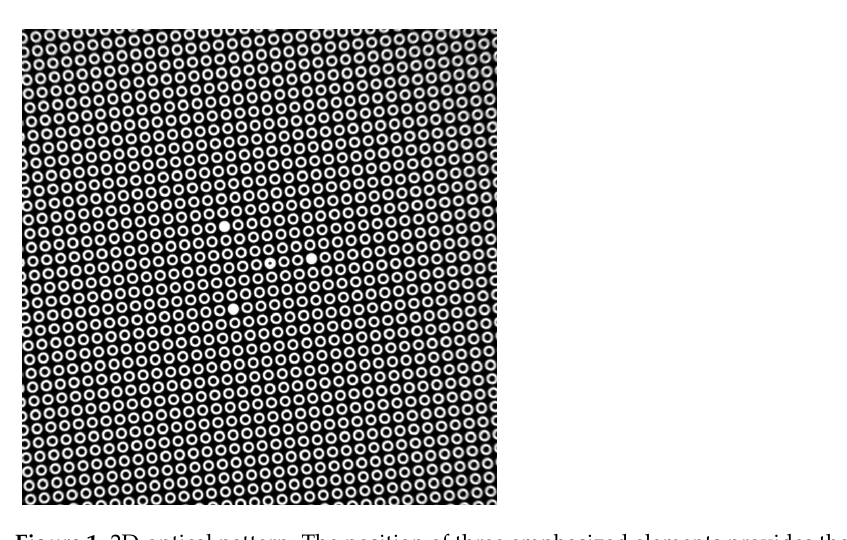
Figure 1. 2D-optical pattern. The position of three emphasized elements provides the non-equivocal determination of the pattern orientation.